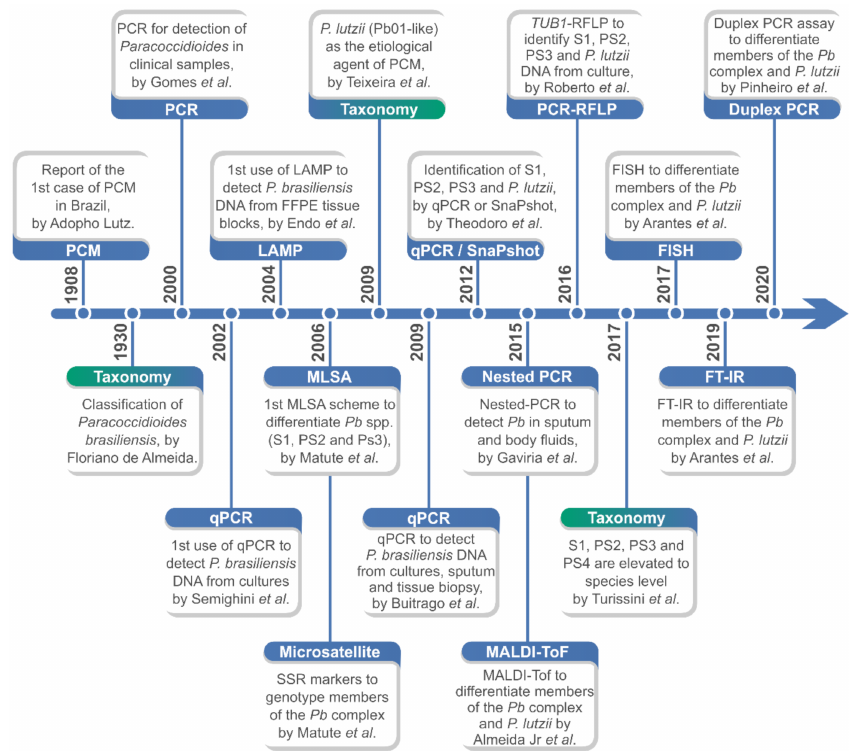
Figure 5. Major developments in the identification and molecular / proteomic characterization of Paracoccidioides